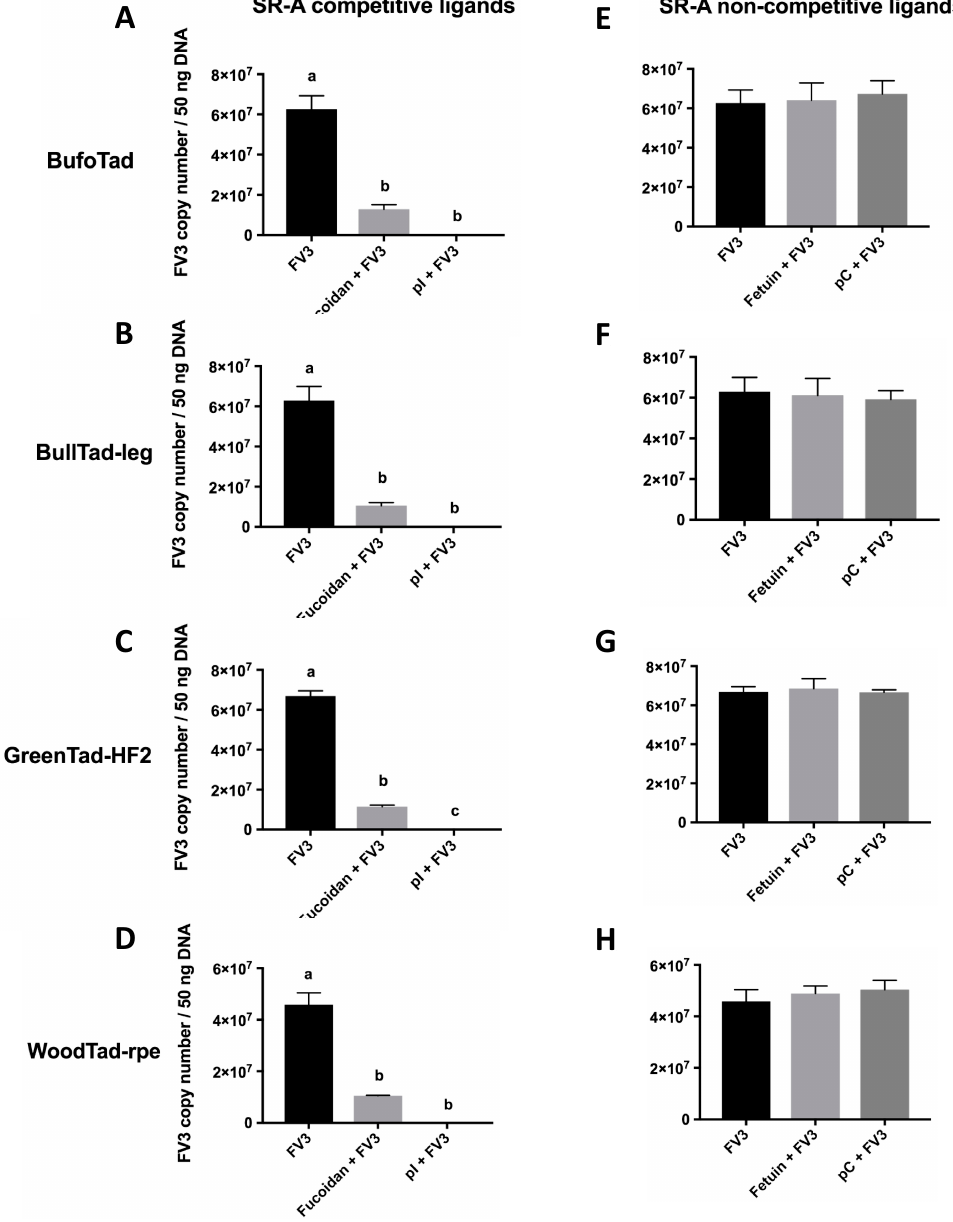
Figure 1. Effects of SR-A competitive and non-competitive ligands on the cell-associated FV3 loads in four tadpole cell lines. The American toad BufoTad cell line, bullfrog BullTad-leg cell line, green frog GreenTad-HF2 cell line, and wood frog WoodTad-rpe cell line were pre-treated with 250 µ g/mL of the SR-A competitive ligands (fucoidan, poly inosine (pI)) ( A – D ) or non-competitive ligands (fetuin, poly cytosine (pC)) ( E – H ) for 30 min. FV3 was added at an multiplicity of infection MOI of 1.0 for 2 h. The FV3 DNA viral loads were determined by absolute qPCR. Data are presented as means ± SEM ( n = 3). Statistical analysis using a one-way ANOVA test and Tukey’s multiple comparisons test with 95% confidence intervals was performed. p values less than 0.05 are considered statistically significant. Groups with different letters are statistically different from one